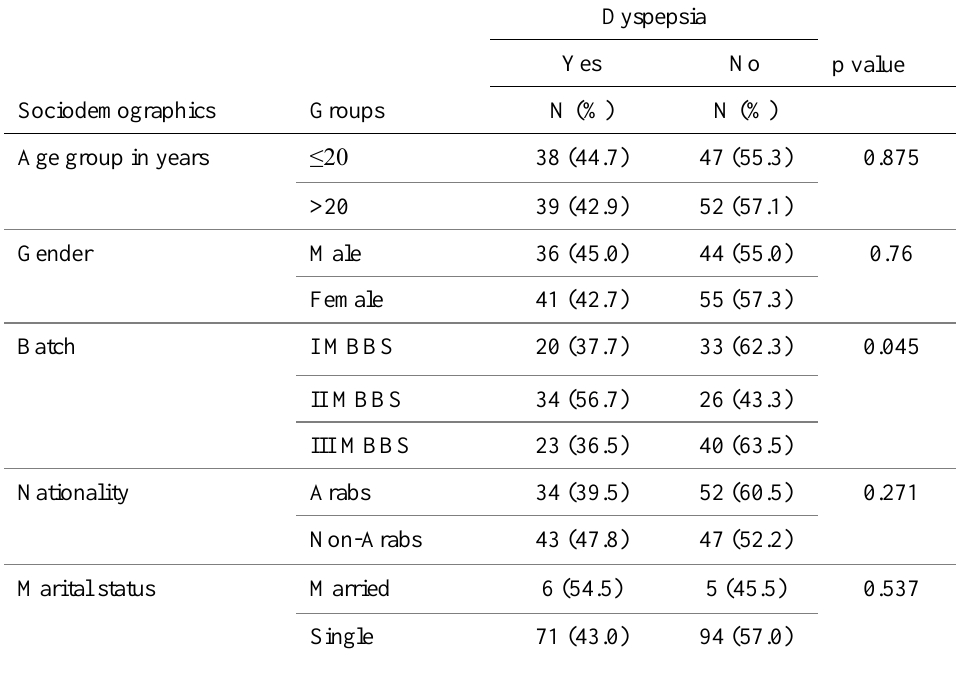
Table 3: Association between sociodemographic characteristics and dyspepsia